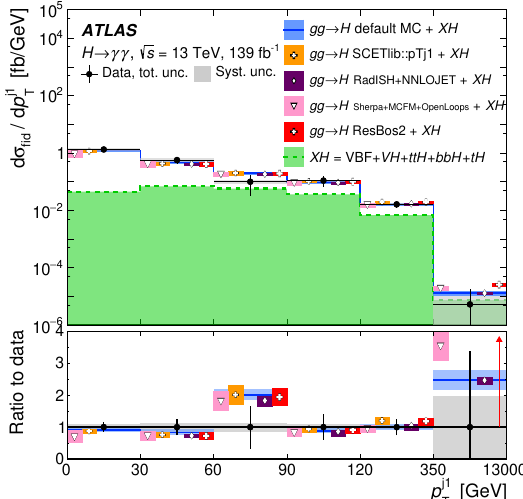
. The T are available only for p j 1 > 30 GeV , whereas T T